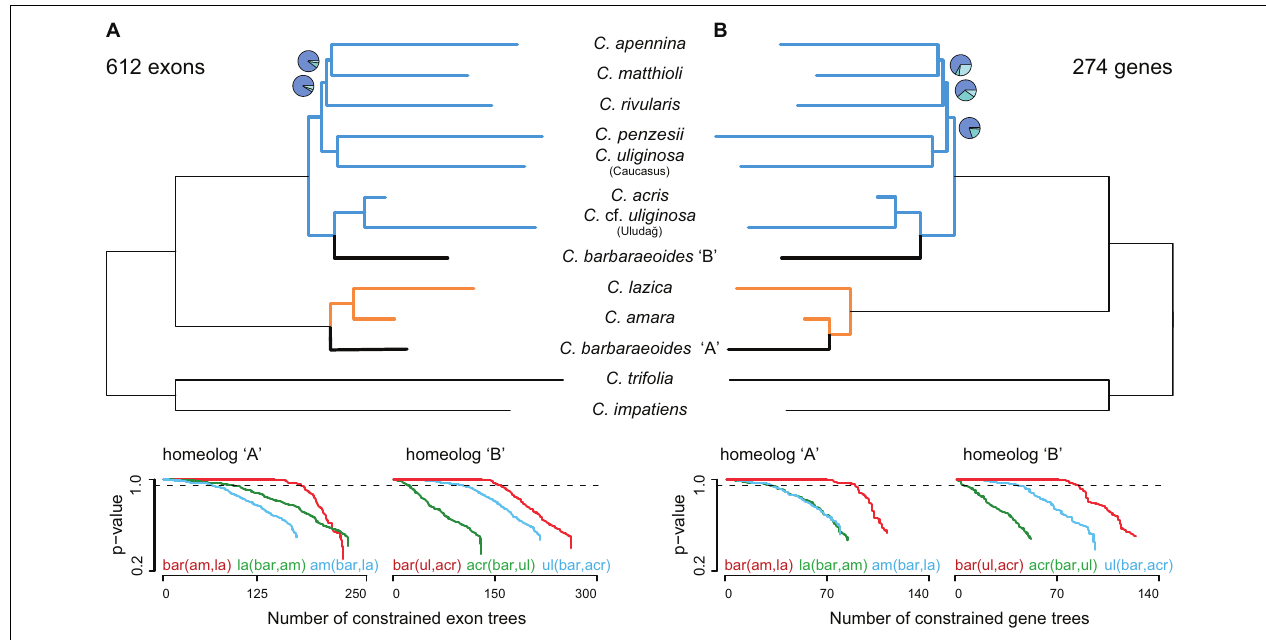
FIGURE 5 | Phylogenetic analyses based on phased allele sequences of 612 exons (A) or 274 genes (B) , for which alleles of all three accessions of Cardamine barbaraeoides were successfully phased and sorted into A and B homeologs. Species trees were inferred in ASTRAL-III. Branch support is indicated by pie charts, depicting three local posterior probabilities for the given branch (not shown for the fully supported branches). Tree branches are colored according to the group membership; branches in black show C. barbaraeoides . The plots below the trees show GGI analyses, testing different phylogenetic placements of the A and B homeologs of C. barbaraeoides . The plots depict the cumulative number of constrained gene trees, which support the given topology, and their P values obtained from the approximately unbiased (AU) tests. Curves above the dashed lines indicate the number of trees that support the given topology significantly better ( P ≤ 0.05) than the alternative ones. The tested topologies were as follows: homeolog A, red: C. barbaraeoides “A” being sister to the clade of Cardamine amara and Cardamine lazica , green: C. lazica being sister to the clade of C. amara and C. barbaraeoides “A”, blue: C. amara being sister to the clade of C. barbaraeoides